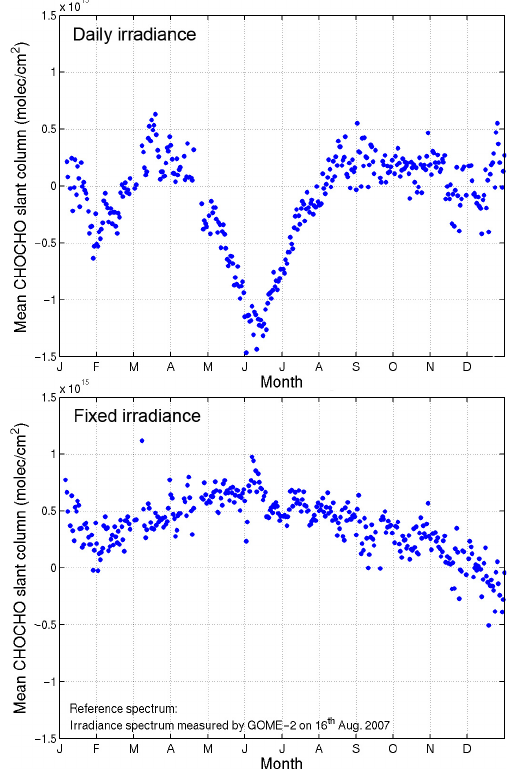
Fig. 6. Time variation of the glyoxal SCDs daily averaged in the sector (15 ◦ N–45 ◦ N; 30 ◦ W–60 ◦ W) in 2007. The upper panel shows the results retrieved using the daily GOME-2 irradiance spec- tra; those obtained using a fixed irradiance spectrum (recorded by GOME-2 on 16 August 2007) are presented in the lower